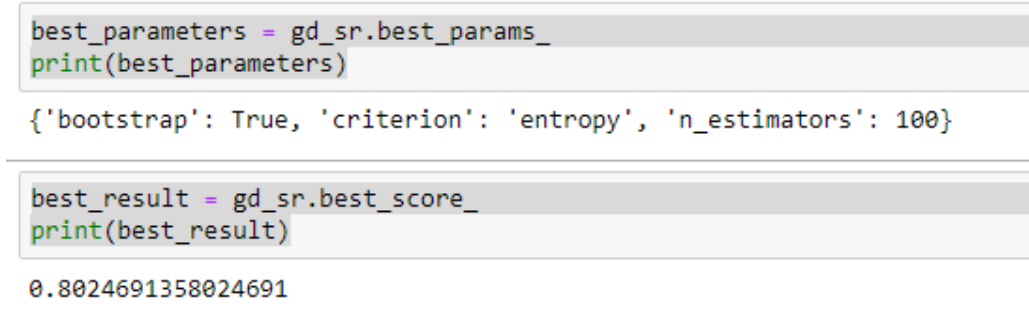
Figure 18. The best parameters with obtained after performing Grid Search with 5-Fold Cross-Validation on the RF model. Table 4. Accuracies achieved by performing 10-Fold Cross-Validation on the RF model.